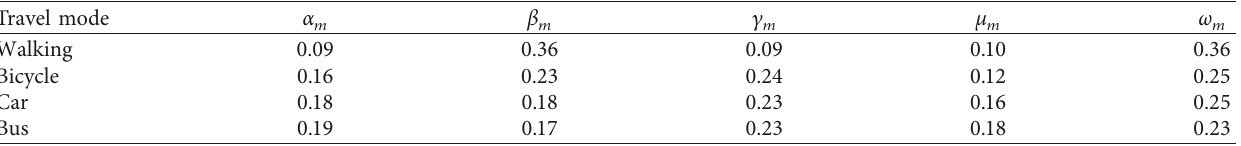
Table 2: Logit model parameter calibration values for travel modes in Academy Street historic